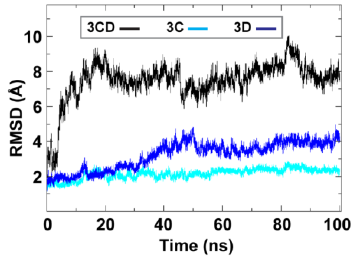
Figure 2. Root-mean-square deviations (RMSD) analysis of the Molecular Dynamics (MD) trajectory reveals large domain movements relative to crystal structure. The RMSD for the backbone atoms of the full-length 3CD (black), of the domains 3C (cyan) and 3D (blue) are plotted as a function of time. The RMSD calculated for 3C and 3D domains showed much lower values than that calculated for 3CD. The dramatic increase in RMSD values for the full-length 3CD during the first 10 ns of the simulations suggested a large domain motion of the precursor protein. Moreover, the lower RMSD values of 3C-domain compared to that of 3D-domain indicated less dynamics of 3C-domain compared to 3D-domain.